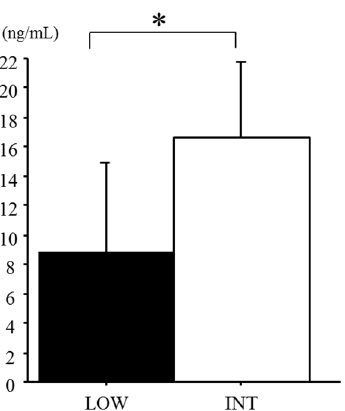
Figure 2. Comparison of serum hepcidin levels between LOW and INT. Values are means ± SD. * p < 0.05 between the periods.